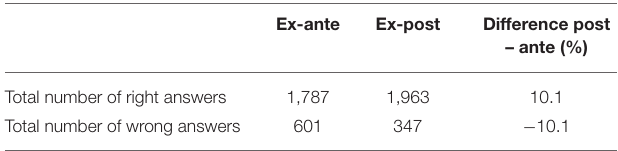
TABLE 1 | Summary of the results from tests obtained in 12 primary classes that conducted the